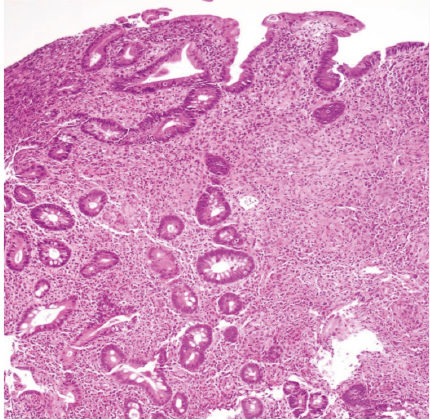
Figure 3: Colonic mucosa showing marked architectural dis- tortion and crypt branching, increased lymphoplasmacytic and